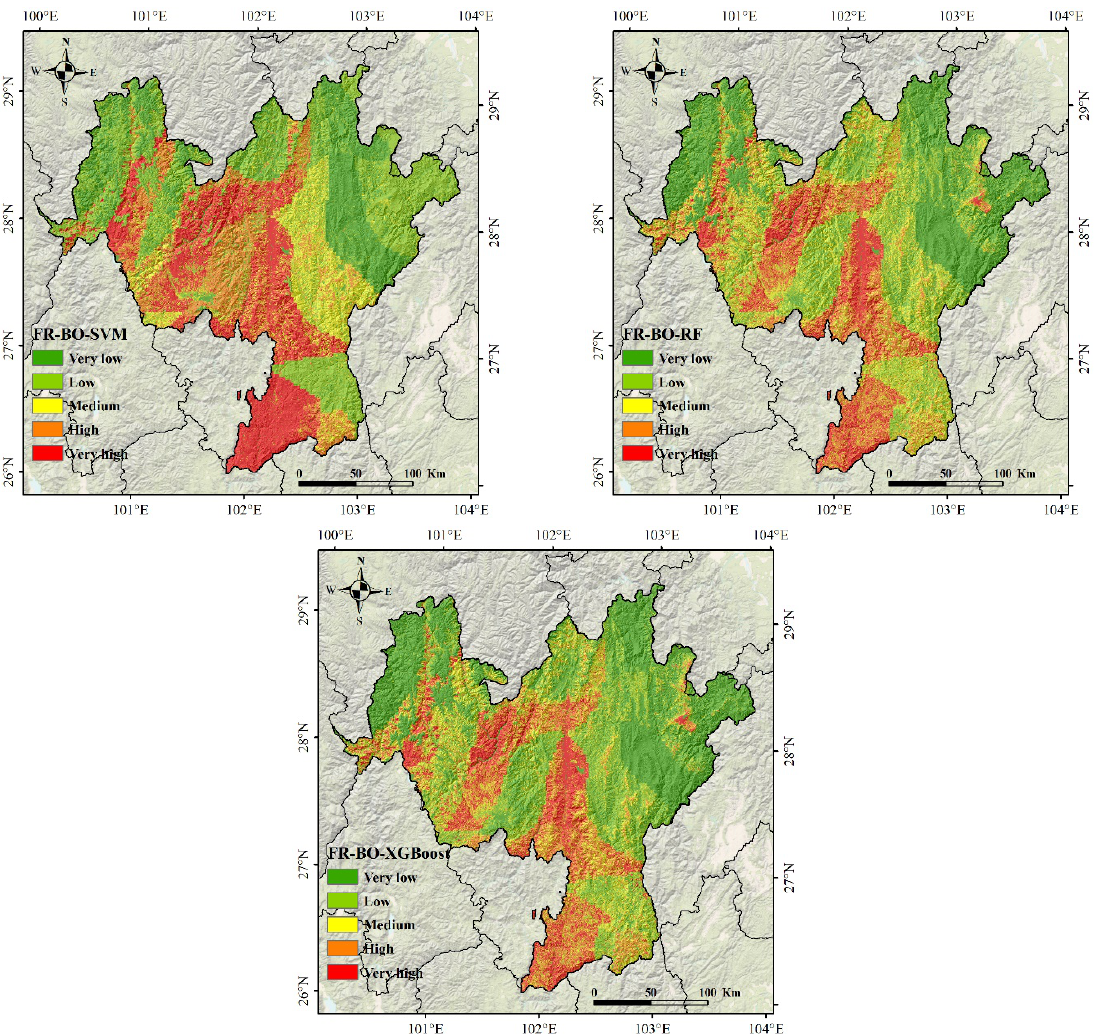
Figure 3. Risk assessment mapping results of three machine learning models.